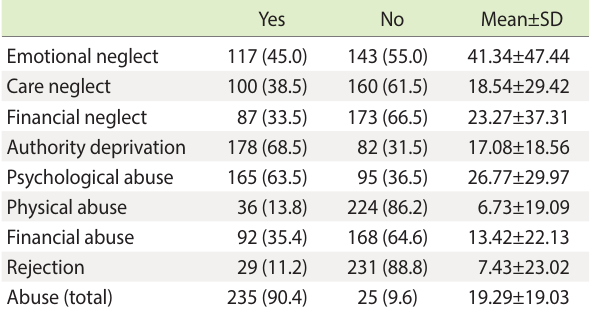
Table 2. Mean score and prevalence of elder abuse and its subscales